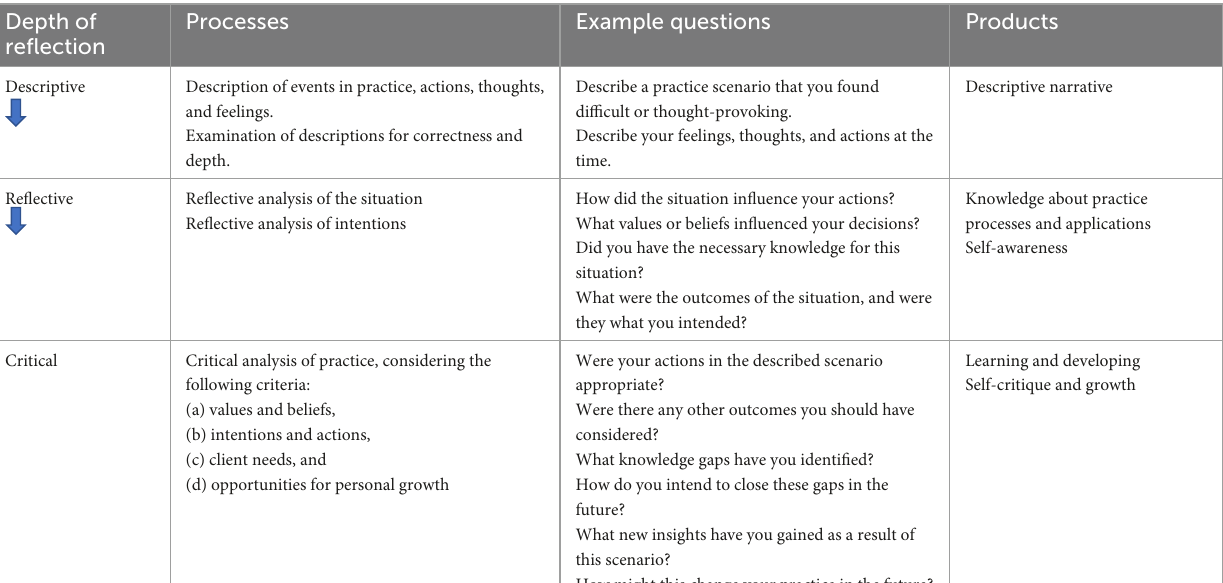
TABLE 4 An adapted version of the critical reflective inquiry model by Kim